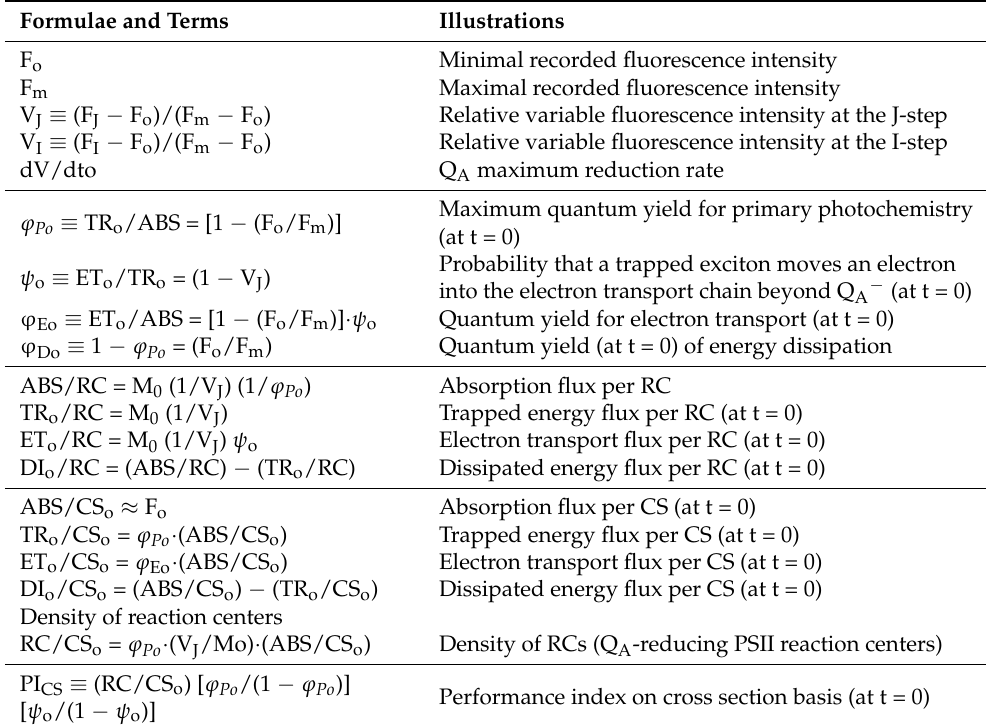
Table 1. Formulae and terms used by the JIP-test for the analysis of the fluorescence transient O-J-I-P. Formulae and Terms